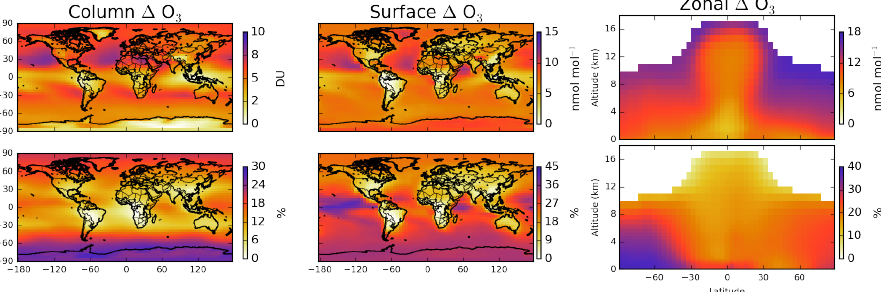
Figure 12. Change in tropospheric O 3 on inclusion of halogen chemistry. Column (left), surface (middle), and zonal (right) changes are shown. Upper plots show absolute change and lower plots below give change in % terms ((“Cl + Br + I” − “NOHAL”) / “NOHAL” · 100).